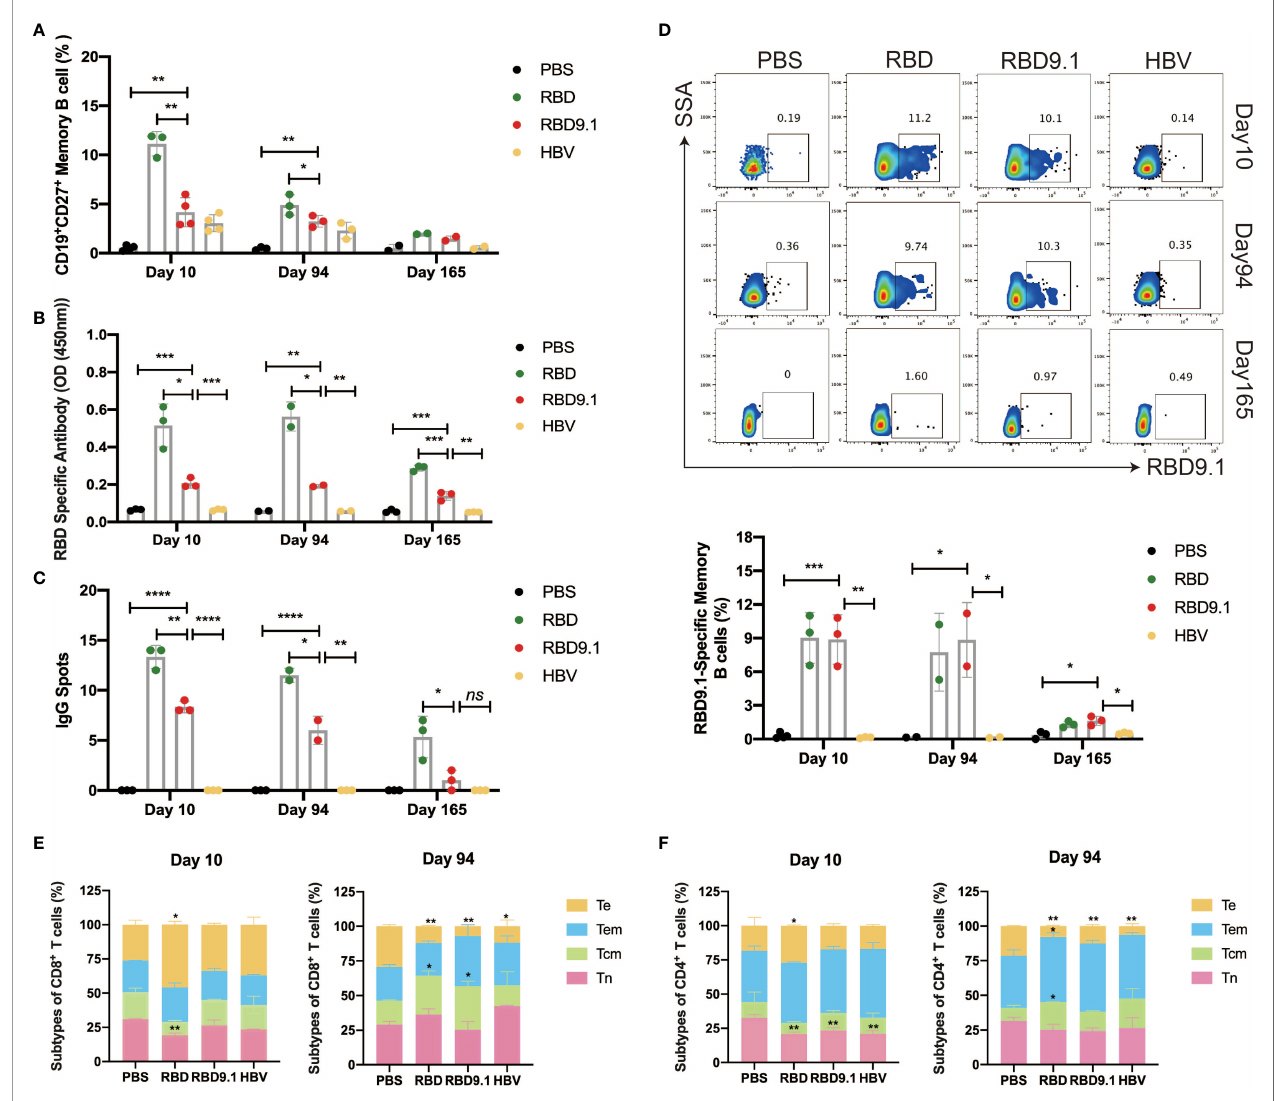
FIGURE 5 | RBD9.1 induced both memory B cells and T cells. (A) The percentages of CD19 + CD27 + memory B cells (gated on CD19 + B cells) from the splenocytes were detected by fl ow cytometry on the 10th, 94th, and 165th day after the last immunization. R848 (2 m g/ml) combined with 100 U mouse IL-2 was used to induce memory B cells to differentiate into plasma cells on days 10, 94, and 165 after the last immunization. (B) Receptor-binding domain (RBD)-speci fi c immunoglobulin G (IgG) antibodies in the supernatant of 2 × 10 6 splenocytes per ml were detected by ELISA. (C) Stimulation with R848 and IL-2 for 6 days, the ELISPOT picture showed the numbers of RBD-speci fi c IgG spots per 5 × 10 5 splenocytes of each mouse, subtracted those from the corresponding DMSO groups. The stimulation with an equal volume of media was performed as the negative control. Data were representative of two independent experiments. (D) RBD9.1-speci fi c memory B cells (gated on CD19 + CD27 + B cells) were detected by fl ow cytometry on days 10, 94, and 165 after the last immunization. (E, F) The ratio of Tn (CD62L + CD44 - ), Te (CD62L - CD44 - ), Tem (CD62L - CD44 + ), and Tcm (CD62L + CD44 + ) of CD8 + or CD4 + T cells on days 10 and 94 after the last immunization. * P < 0.05, ** P < 0.01, *** P < 0.001, **** P < 0.0001; ns, non-signi fi